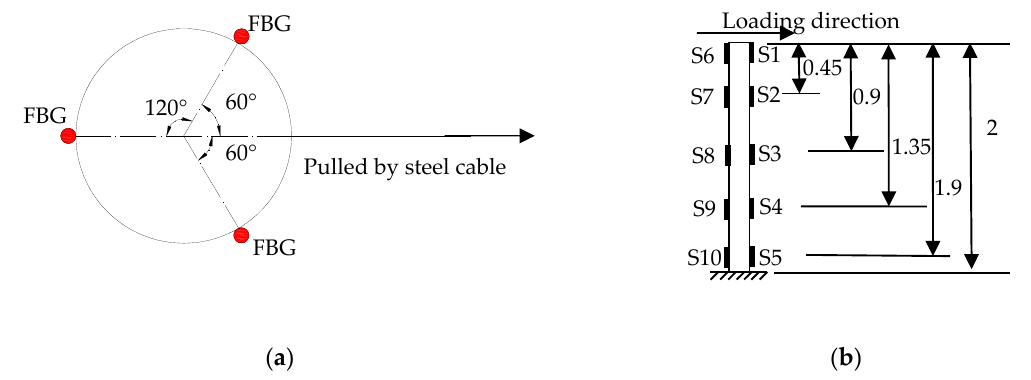
Figure 12. Layout of sensors: ( a ) FBG sensors; ( b ) Strain gauges (unit: m).